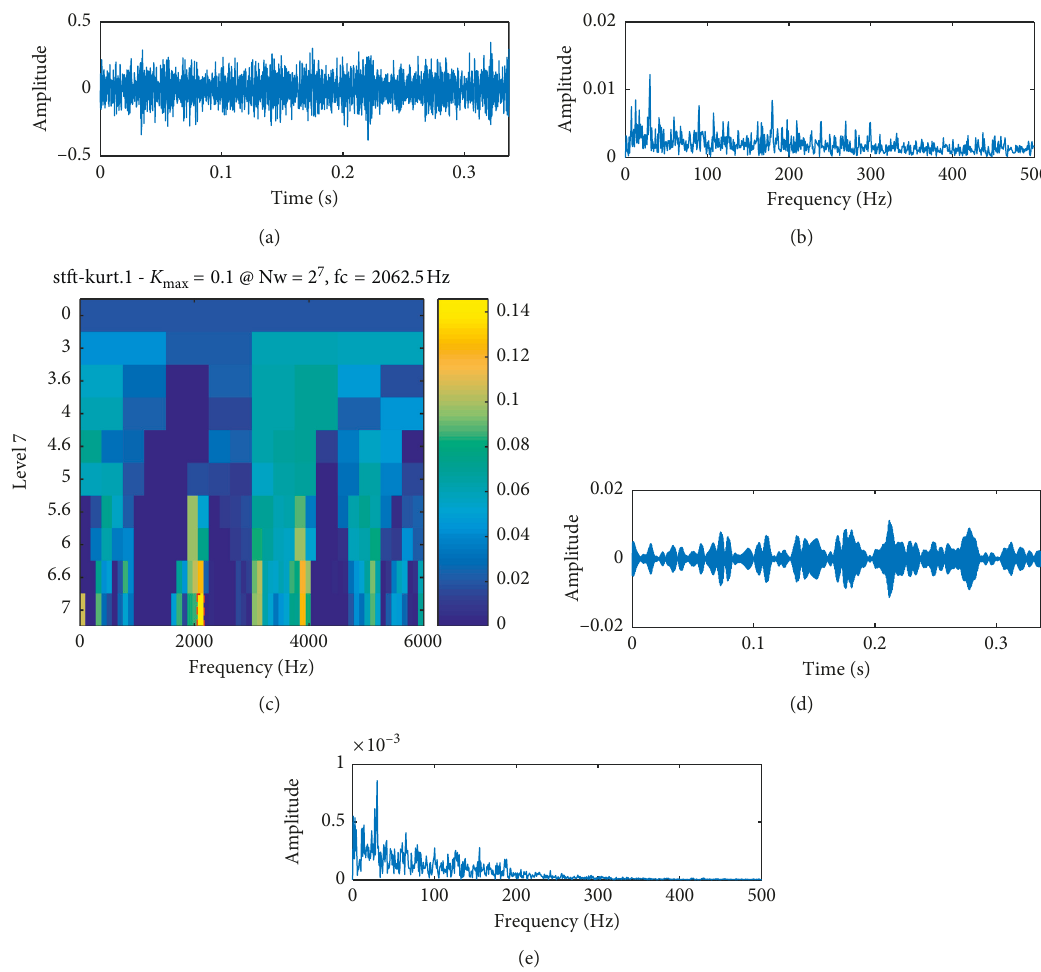
Figure 12: Diagnosis results of the single fault experimental signal by EEMD-FSK: (a) TW of the reconstruction signal obtained by EEMD; (b) ES of (a); (c) kurtogram; (d) TW of the filtered signal obtained by FSK; (e) ES of